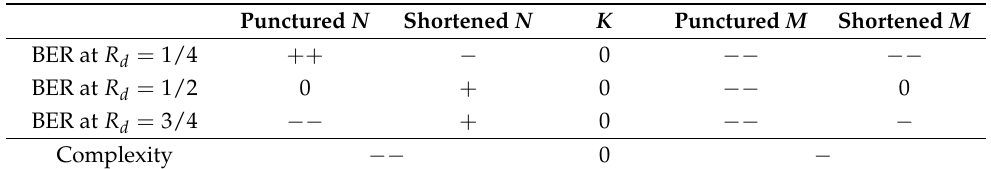
Table 5. Tabulated observations from Scenario 1.